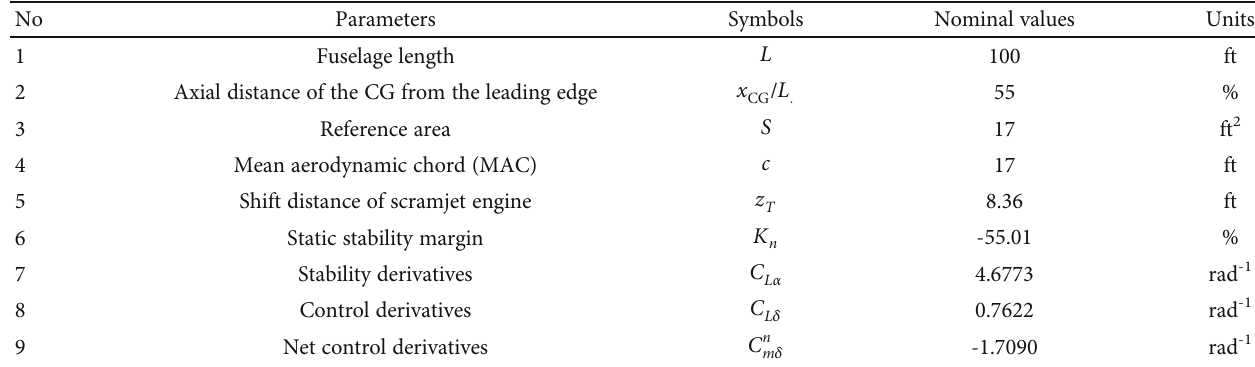
Table 2: Parameters of the HFV model.